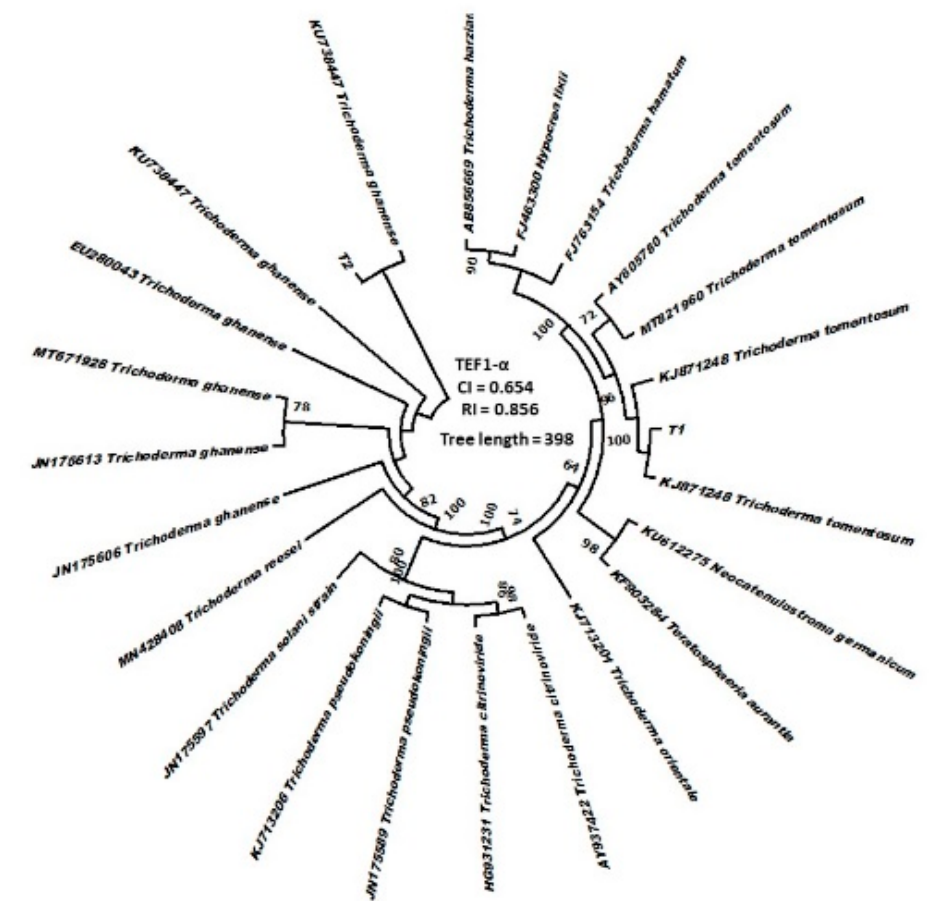
Figure 2. Phylogeny of Trichoderma isolates based on ITS1-5,8S-ITS2 and TEF1 loci. The most parsimo- nious tree for each locus with appropriate length is shown. CI—consistency index, RI—retention index. The percentage >50% of replicate tree is shown next to branches.